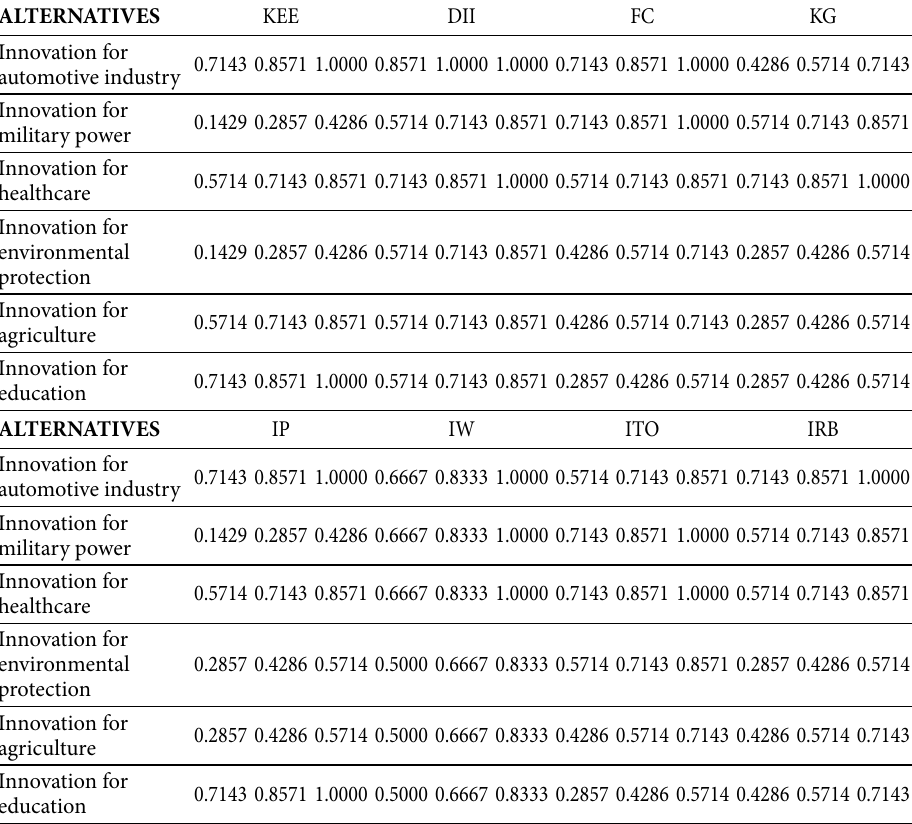
Table 4. Normalized fuzzy decision matrix